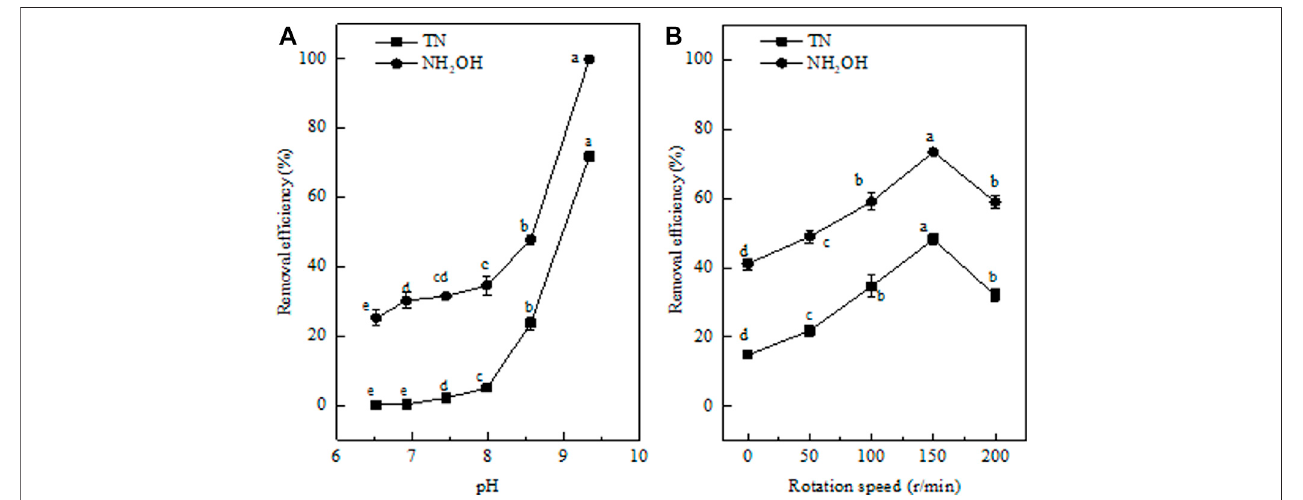
FIGURE6| Effectoffactors on hydroxylamine removal abilityofstrain EM-A1. pH (A) ,rotation speed (B) .Values arepresented asthemeans ± SD oftheresults of three replicates (error bars). Different letters indicate signi fi cant differences between treatments at p < 0.05.